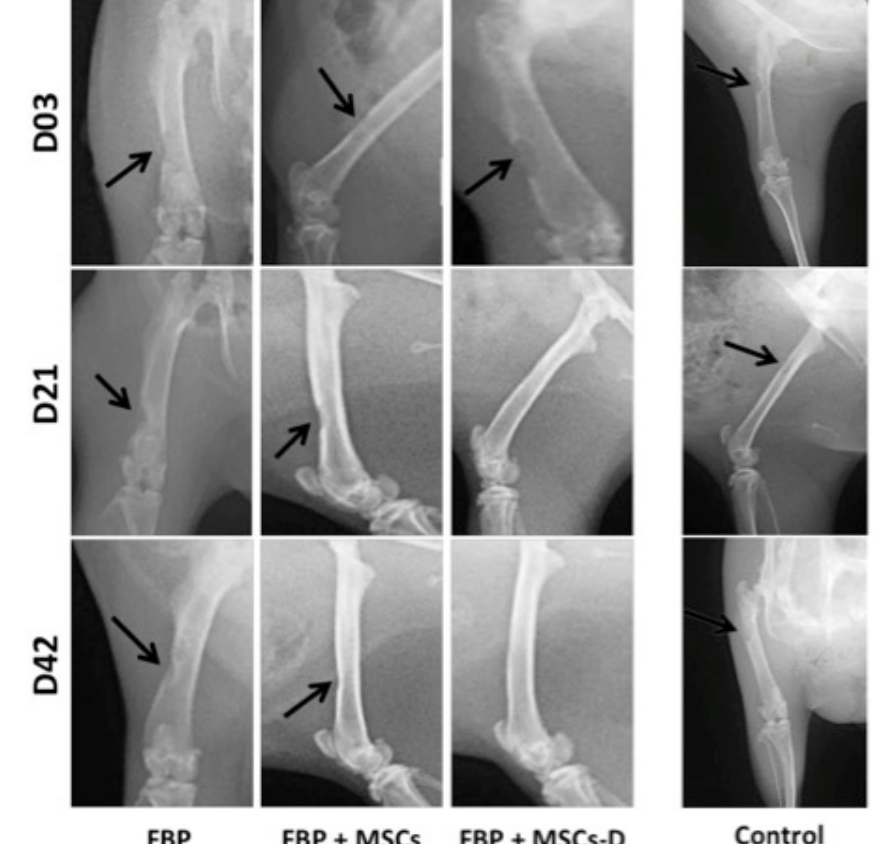
Figure 2. Radiographic analysis of bone injury in femur of rats at 3, 21 and 42 days post injury. FBP (fibrin biopolymer only); FBP + MSCs (fibrin biopolymer + mesenchymal stem cells); FBP + MSC-D (fibrin biopolymer + differentiated mesenchymal stem cells). Control shows non-treated bone for comparison.